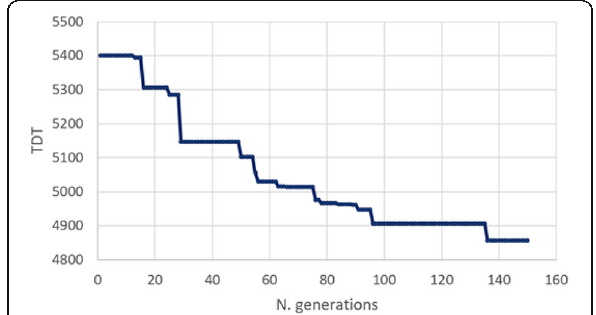
Fig. 5 Convergence curve of the objective